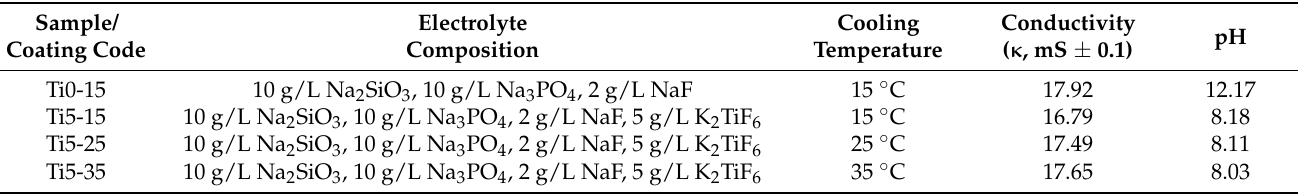
Table 1. Identified codes of the MAO-treated samples and their corresponding electrolyte composi- tion, temperature, conductivity and